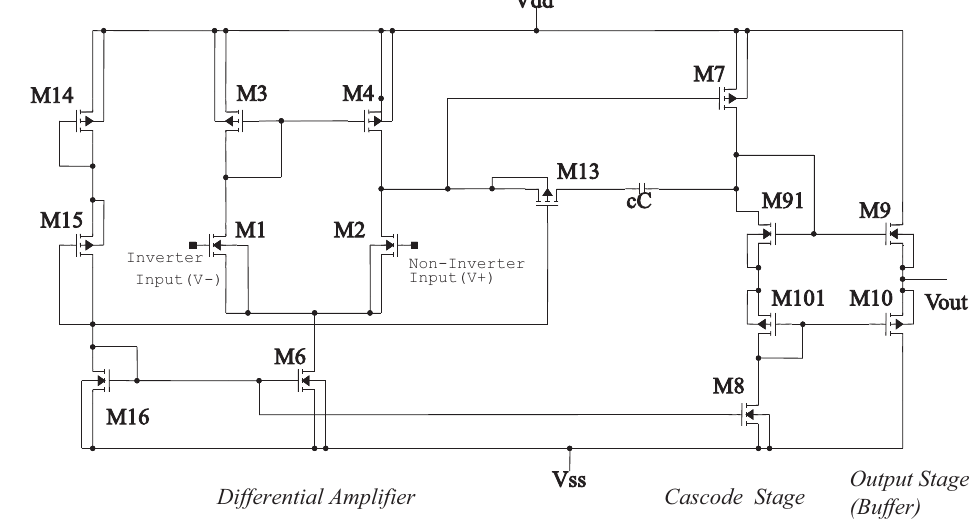
Figure 3. Complete circuit based on ANN.